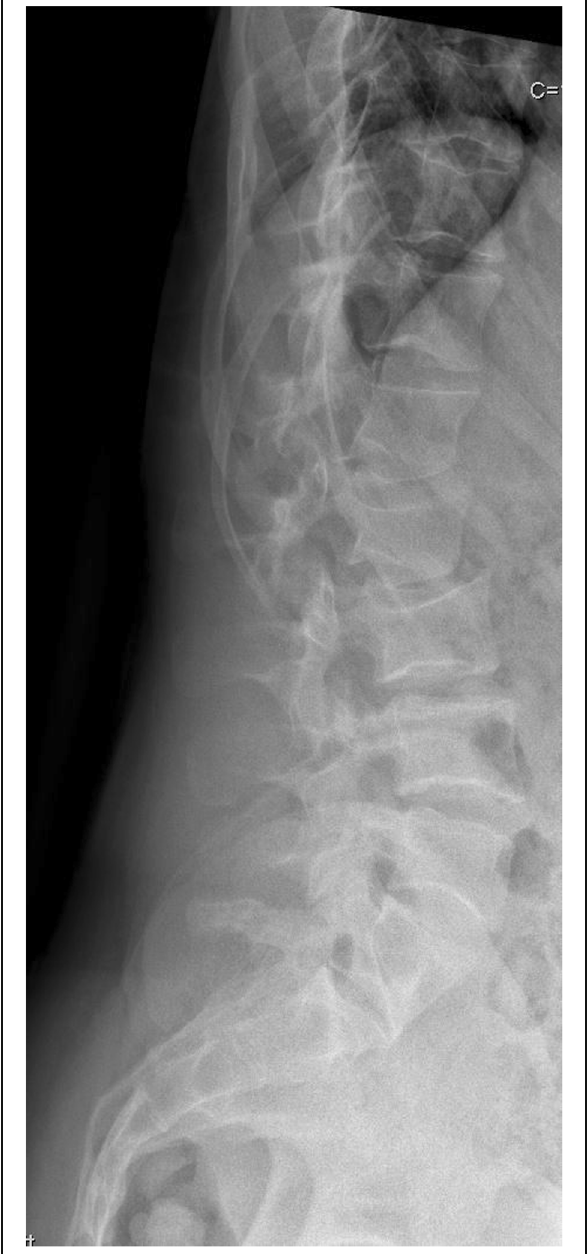
Fig. 4 Lumbar spine at 20 years showing slight platyspondyly with biconcave